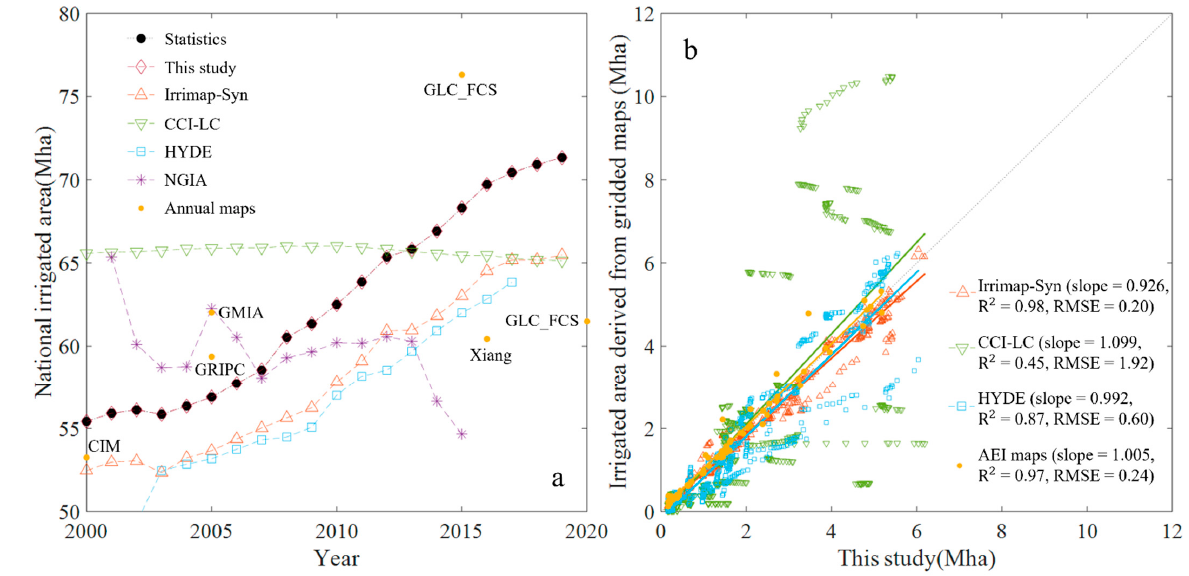
Figure 5. Comparisons among ( a ) national and ( b ) provincial irrigated area in China from different gridded datasets. In sub-figure b, the black dash line is the 1:1 line, and colored lines represent linear regression lines (orange: Irrimap-Syn (slope = 0.926, R 2 = 0.98, RMSE = 1.92), green: CCI-LC (slope = 1.099, R 2 = 0.45, RMSE = 1.92), blue: HYDE (slope = 0.992, R 2 = 0.87, RMSE = 0.60), and yellow: AEI maps (slope = 1.005, R 2 = 0.97, RMSE = 0.24), which were generated by CIM and GMIA-m to regress with this study).